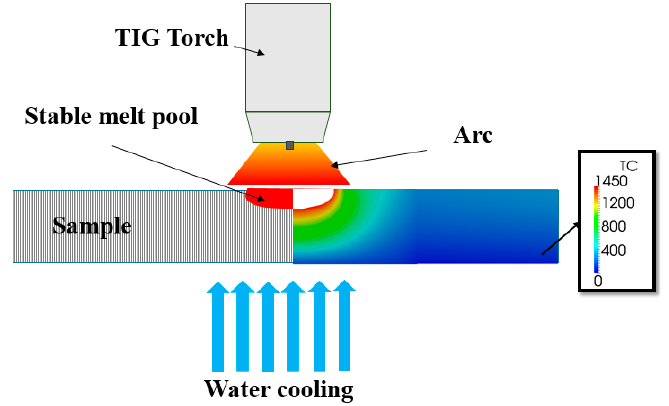
Figure 1. Schematic illustration of arc heat treatment showing a stationary tungsten inert gas (TIG) arc on a super duplex stainless steel (SDSS) disc water-cooled from the backside. A steady-state